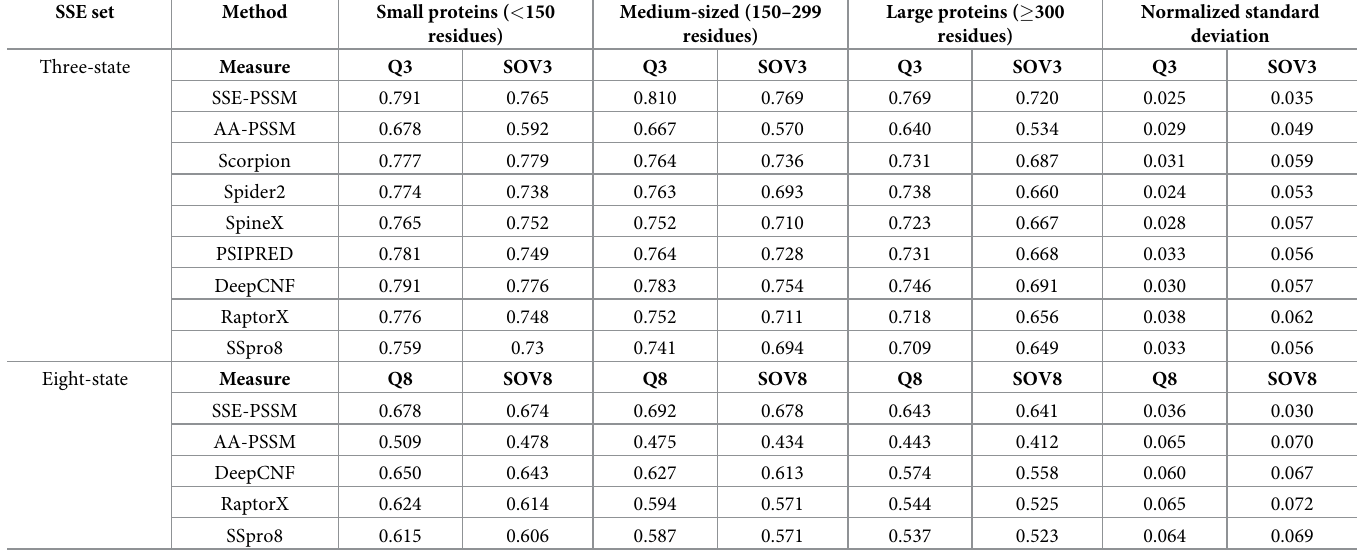
Table 3. Accuracy of several SSP methods for proteins of different